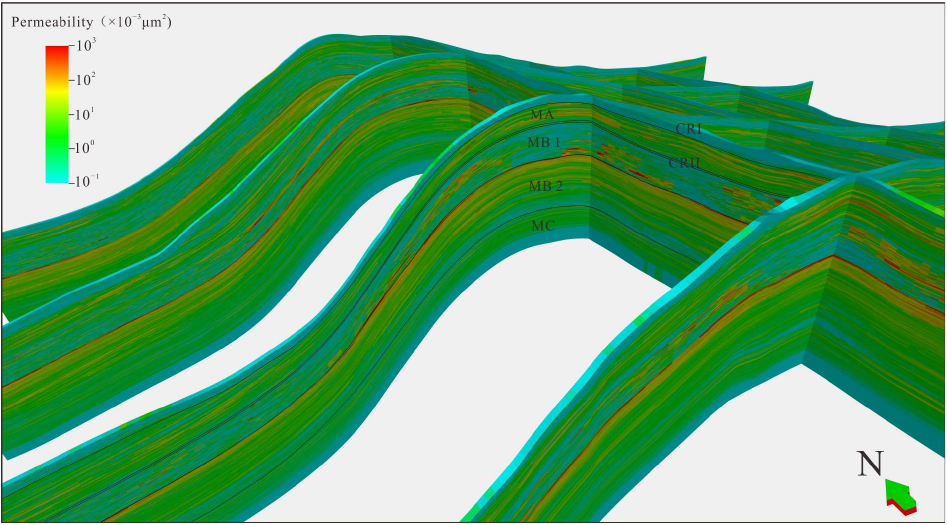
Figure 10. Permeability model of the Mishrif Formation in X Oilfield.